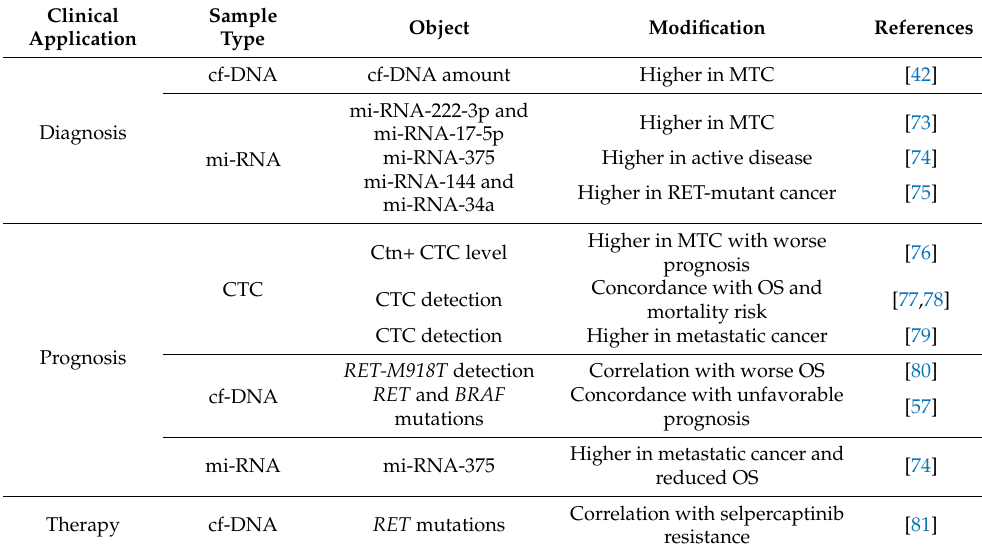
Table 3. Potential implications of liquid biopsy for the diagnosis, prognostic definition, and therapy of medullary thyroid